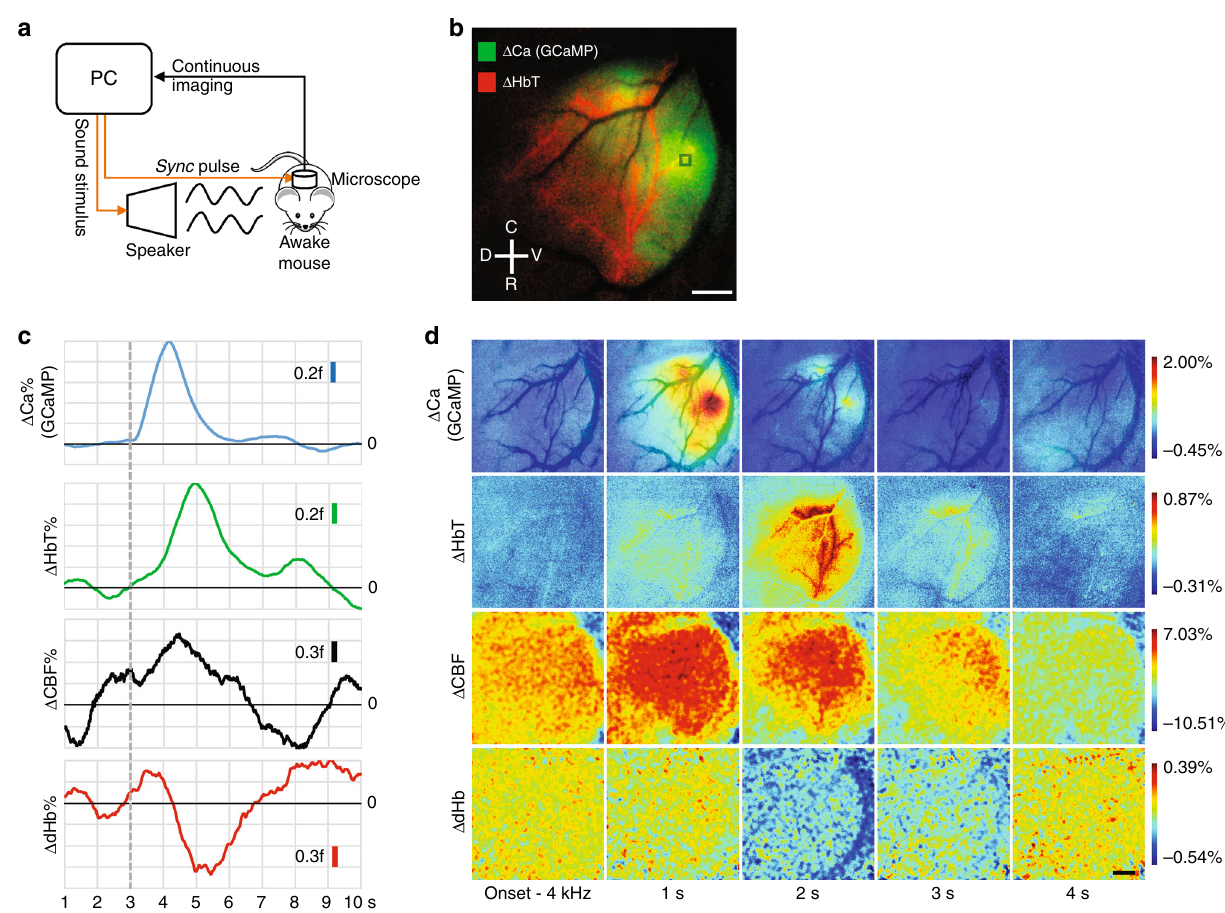
Fig. 3 Localized neural and global hemodynamic response to auditory stimulation. a Schematic of the experimental setup for the auditory stimulation and image acquisition. b A composite (i.e., RGB) map showing the maximum calcium response (green channel) and the corresponding maximum vasodilatory response (HbT, red channel) to a 4 kHz stimulus. Anatomical directions dorsal (D) — ventral (V), caudal (C) — rostral (R) are provided for reference. The black background image is a vessel mask (i.e., binarized version of the blood vessel image) underlay. c Time series of the calcium and hemodynamic responses to a 4 kHz stimulus from the 20 × 20 pixel region of interest (ROI) shown in b . The ordinates for each plot are in fractions ( f ) of the peak response amplitude. The black line indicates the baseline for each trace and the hashed gray line indicates when the stimulus was presented. A sliding 1